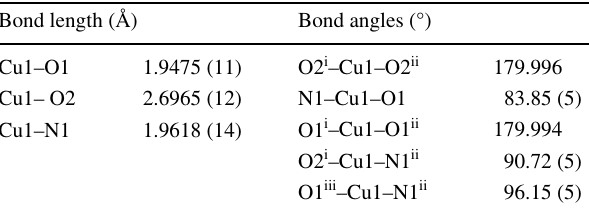
Table 2 Selected bond distances (Å) and angles (°) for CP-1